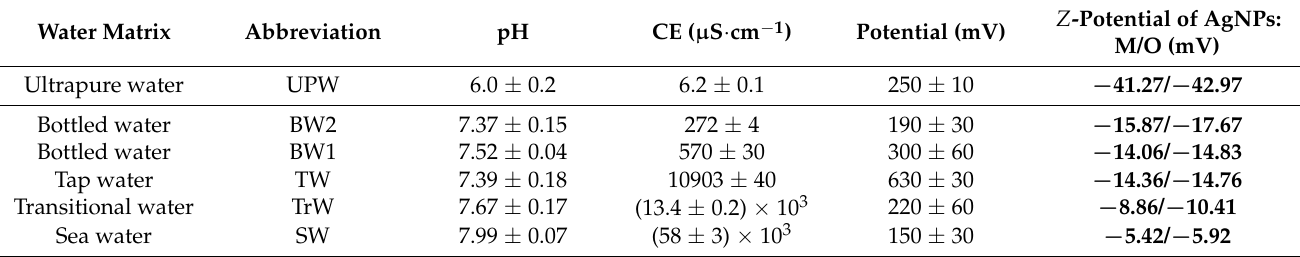
Table 3. pH, electrical conductivity (EC) and redox potential for each aqueous matrices used. Z -potentials for M and O batches of AgNPs diluted 1:4 with several water matrices (see the experimental section for more explanation.) Water